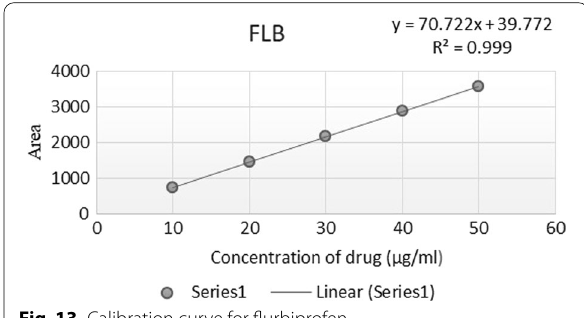
Fig. 13 Calibration curve for flurbiprofen